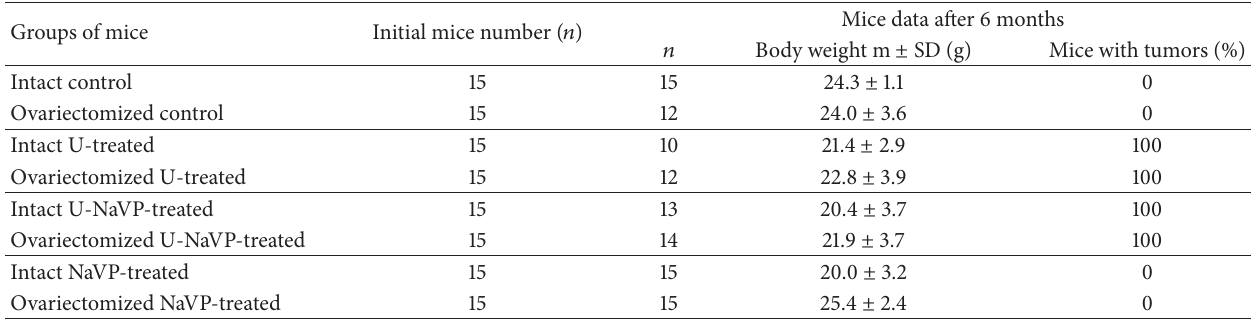
Table 1: Incidence of lung tumors in female BALB/c mice of the study groups.